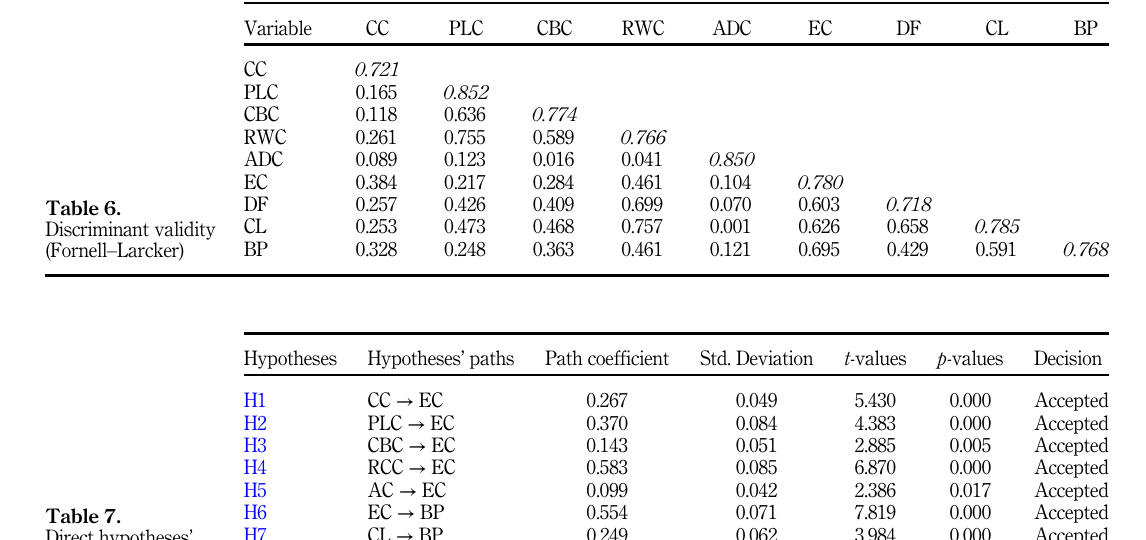
Table 7. Direct hypotheses